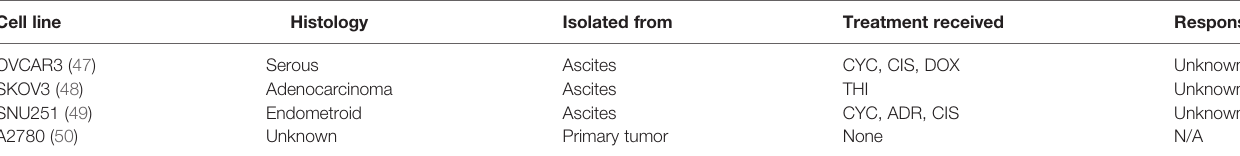
TABLE 1 | Characteristics of ovarian tumors from which cell lines were